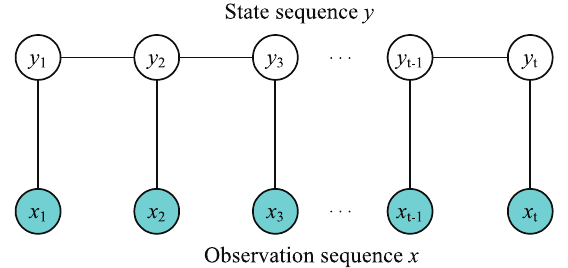
Fig. 1. Structure of conditional random field